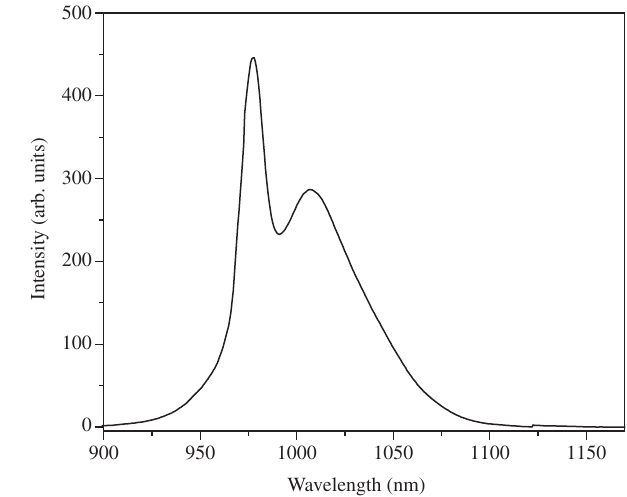
Figure 2. Absorption spectrum of the GP glass doped with 1.0 wt. (%) of Yb O . The inset shows the absorption coefficient as a function of Yb 2 3 concentration.